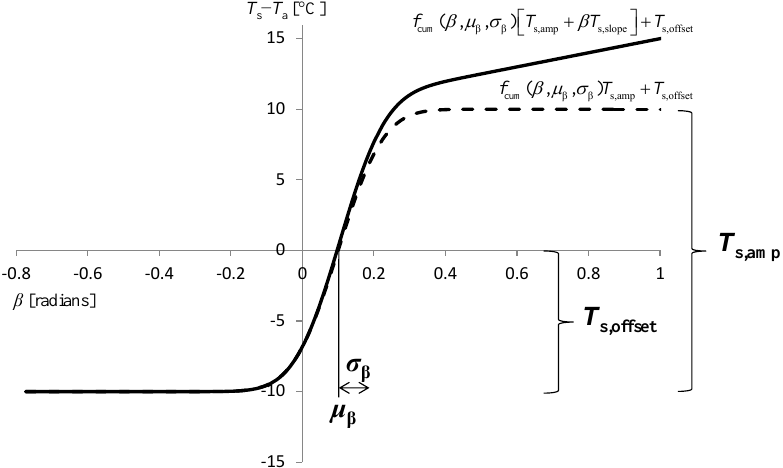
Figure 5. Equation (6) and associated parameters to describe the surface–air temperature difference, substituted for T s in R nl (Eq.